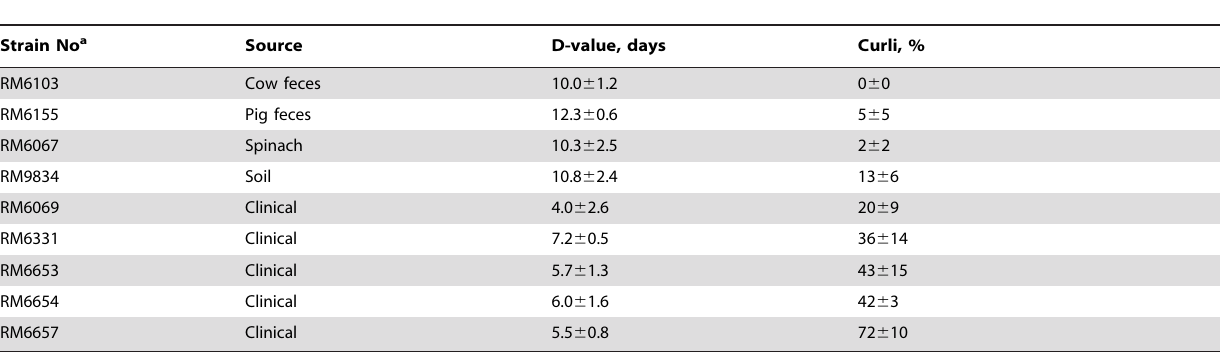
Table 3. EcO157 survival in soil and proportion of curli sub-populations of parental strains.